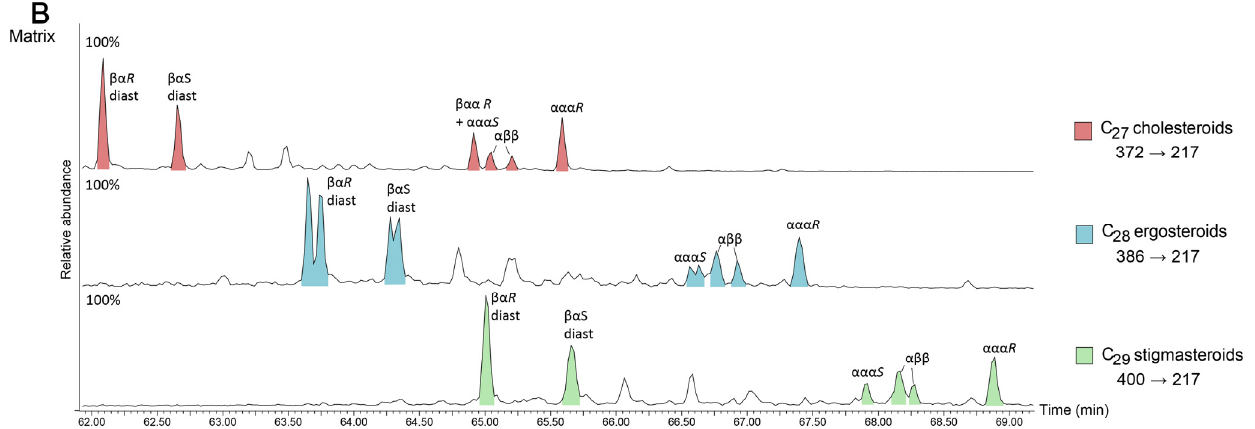
Figure 2. Metastable Reaction Monitoring (MRM) chromatograms of M + → 217 precursor to product transitions of C 27–29 steranes of PE 52316 Fossil ( A ) and Matrix ( B ). Peaks are coloured according to the number of carbon atoms in the sterane. α and β nomenclature refers to the stereochemistry of hydrogen at C-5, C-14 and C-17 for regular steranes and C-13 and C-17 for diasteranes, while S / R refers to stereochemistry at the C-20 position. Percentages represent the relative abundance of the most abundant peak in each transition.